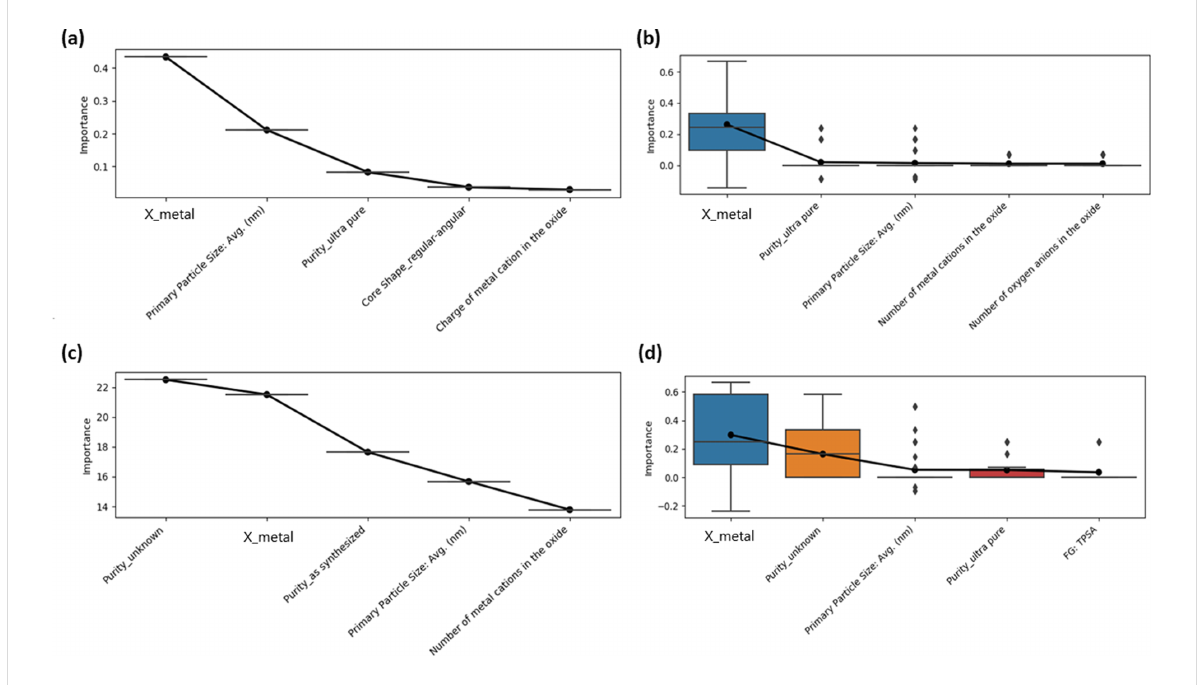
Figure 10: Variable importance estimates for the five most important variables (highest mean importance values) in the original multiple descriptor models, without data augmentation, of excess lethality at 120 hpf. “X_metal” denotes the Pauling metal atom electronegativity descriptor. See section “Descriptor calculations” under the Experimental section for detailed explanations of the names of the other descriptors. (a) Original Gini importance values for a single Random Forest model trained on the entire model development dataset, with hyperparameters tuned via cross-validation. (b) Dis- tributions of permutation variable importance values (change in balanced accuracy after permutation) across ten random permutations of the descriptor values in the validation fold and five folds, for Random Forest models cross-validated on the model development set, with descriptor scaling and hyperparameter tuning repeated for each cross-validation training set. (c) Original coefficient magnitude importance values for a single logistic regression model trained on the entire model development dataset, with partial hyperparameter tuning via cross-validation. (d) Distributions of permu- tation variable importance values (change in balanced accuracy after permutation) across ten random permutations of the descriptor values in the validation fold and five folds, for logistic regression models cross-validated on the model development set, with descriptor scaling and hyperpara- meter tuning repeated for each cross-validation training set. The mean variable importance measures (black circles) are superimposed upon the boxplots of the